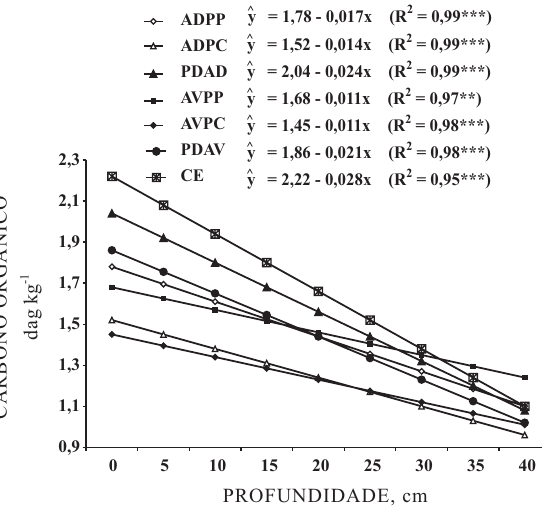
Figura 3. Equações de regressão polinomial não- ortogonal para carbono orgânico ( y ^ , dag kg -1 solo) em função da profundidade (cm), considerando todo o período de estudo. ***, **: Significativos a 1 e 5 %, respectivamente, pelo teste F. Ver quadro 3 para descrição dos